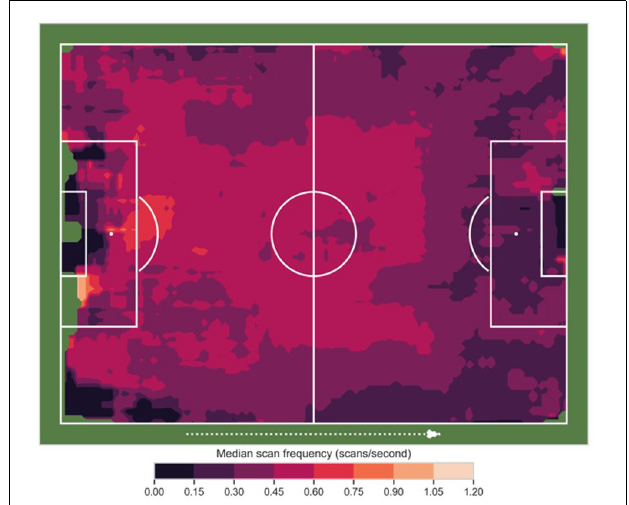
FIGURE 4 | Pitch location and scan frequency. The attacking direction is normalized from left to right (dotted arrow). Colors at a given location ( x,y ,) show the median search frequency calculated from a 12 × 8-m box centered on that